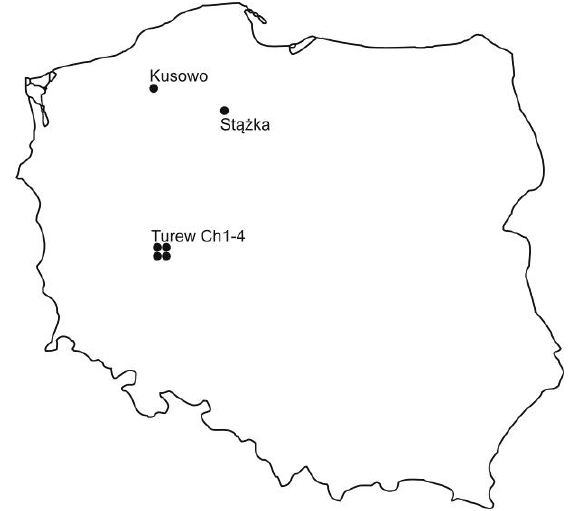
Figure 1. Location of the study sites.